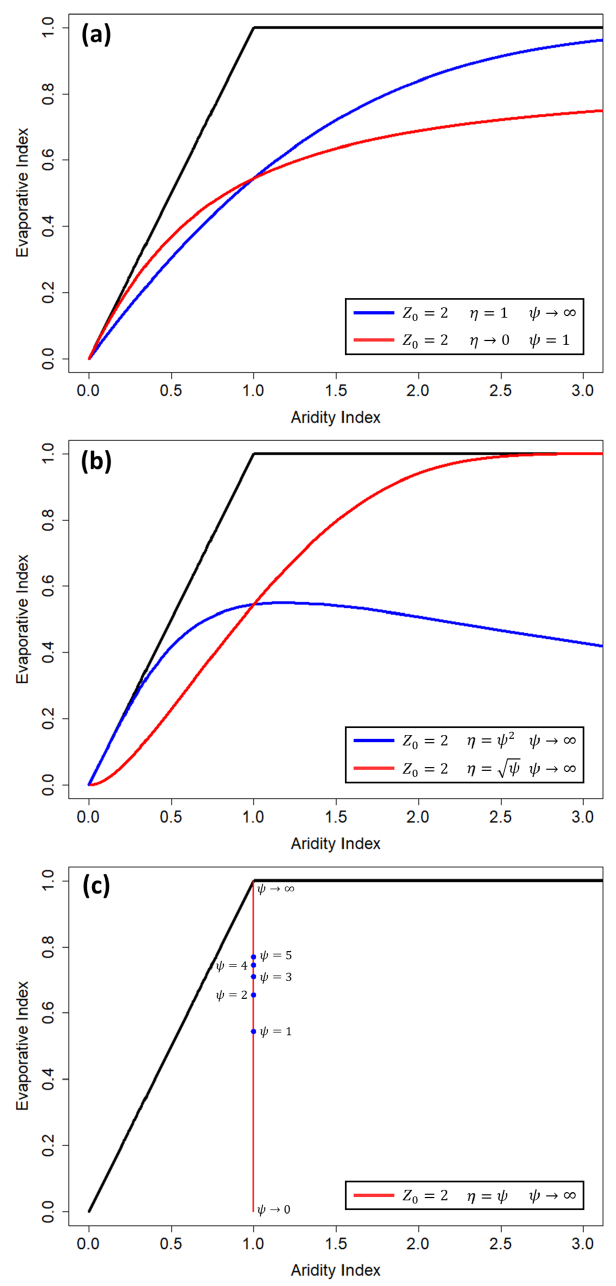
Figure 1. Resulting trajectories of the theoretical test of the Budyko curve conjecture plotted in Budyko space. The energy and water limits of Budyko space are given as solid black lines. (a) Tra- jectories for test case 1, variable storm size (blue), and test case 2, variable storm frequency (red). (b) Trajectories for test case 3, storm-frequency-dominated aridity (blue), and test case 4, storm- size-dominated aridity (red). (c) Trajectory for test case 5, variable precipitation flashiness (red), with locations corresponding to spe- cific values of ψ